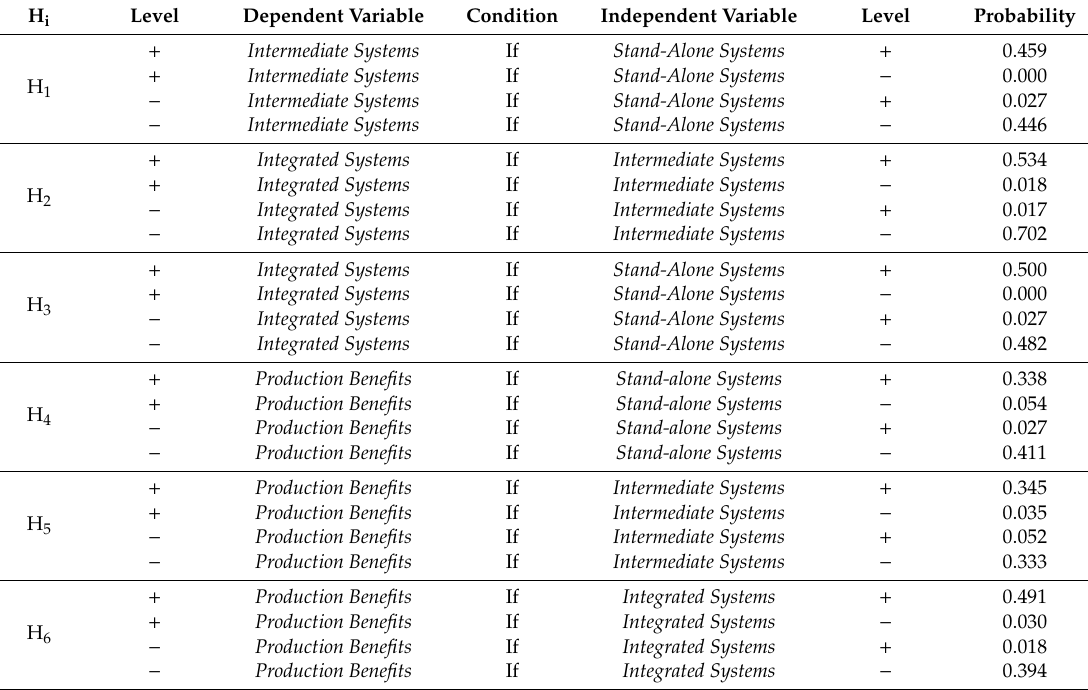
Table 12. Conditional probability